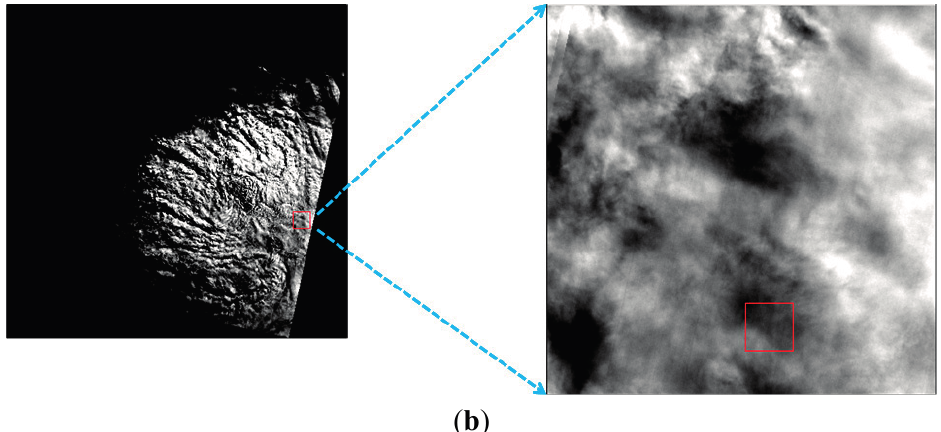
Figure 7. Hard-stretched test image for the cirrus band (WRS-2 12/55, 19 June 2013) zoomed in on FPM 14 with the following relative gains applied: ( a ) diffuser-based; ( b ) deep convective cloud (DCC)-based.